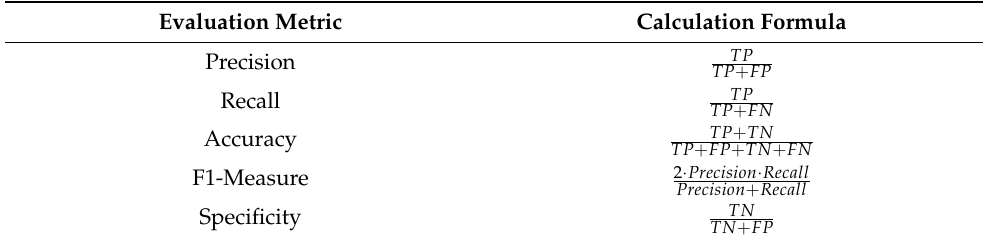
Table 2. Evaluation indicators related to TP, FP, TN, and